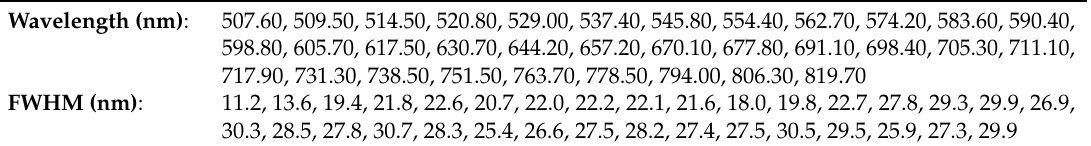
Table 2. Wavelength and full width of the half maximum (FWHM) values of the measured hyperspectral data